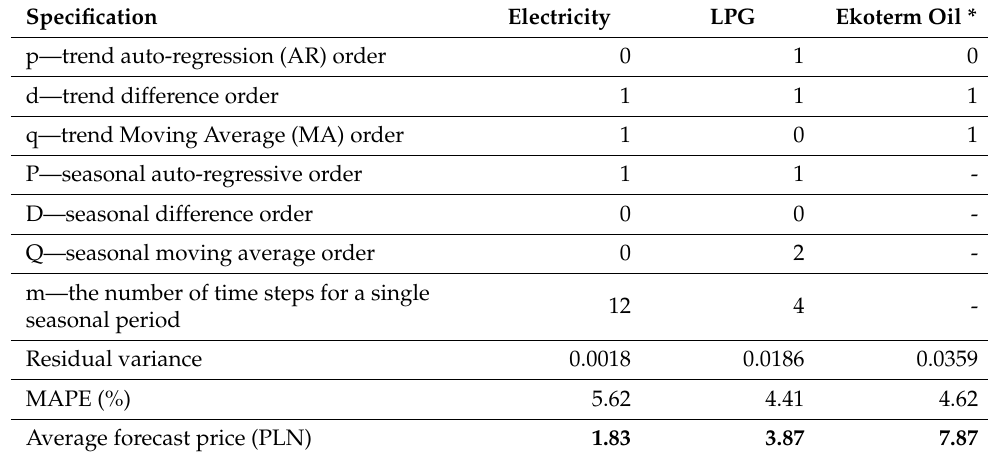
Table 4. Parameters of time series models examining prices of electricity, LPG and Ekoterm oil. Specification Electricity